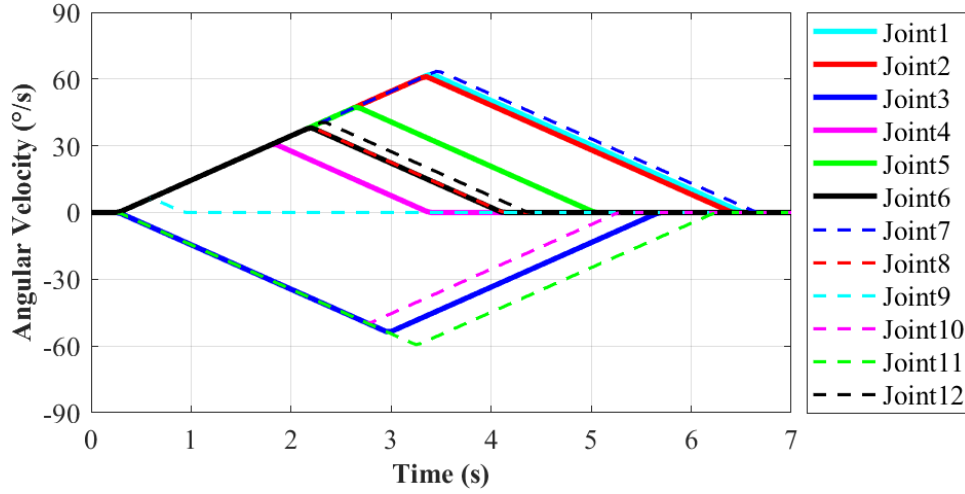
Figure 11. The angular velocity variation of each joint. (Action 9 according to Table 1).